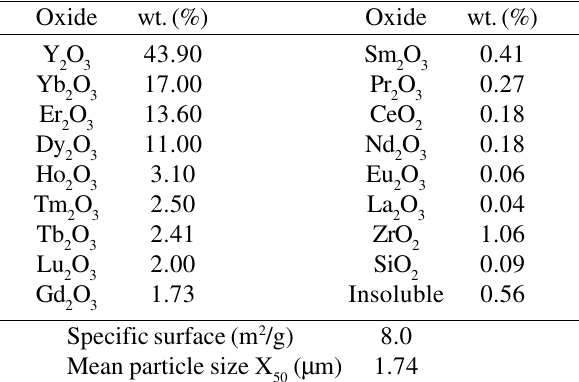
Table 1. Composition of the R sion Spectrometry (ICP-AES), specific surface and mean particle size (X ). 50